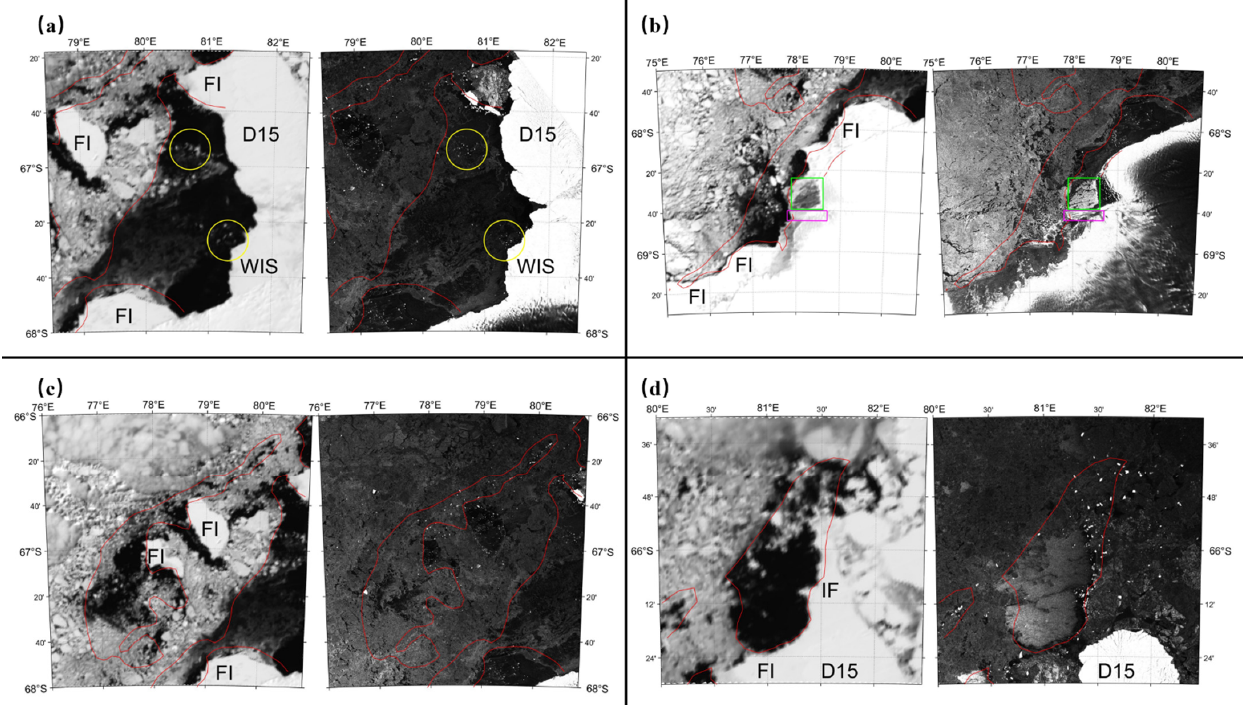
Figure 7. Comparison of MODIS visible images (band 1) and ASAR WSM images to show the construction of the ice barriers of ( a ) BaP, ( b ) DaP, ( c ) FLBP, and ( d ) D15P. The left image in each pair is the MODIS visible image, and the right image is the ASAR WSM image. Important features are labelled: fast ice (FI), ice finger (IF), Iceberg D15 (D15), and West Ice Shelf (WIS). Yellow circles indicate the assemblage of small icebergs inside BaP. The magenta and green boxes indicate a small ice shelf and the island where the Davis Station is located, respectively. The red lines indicate POF = 24%.